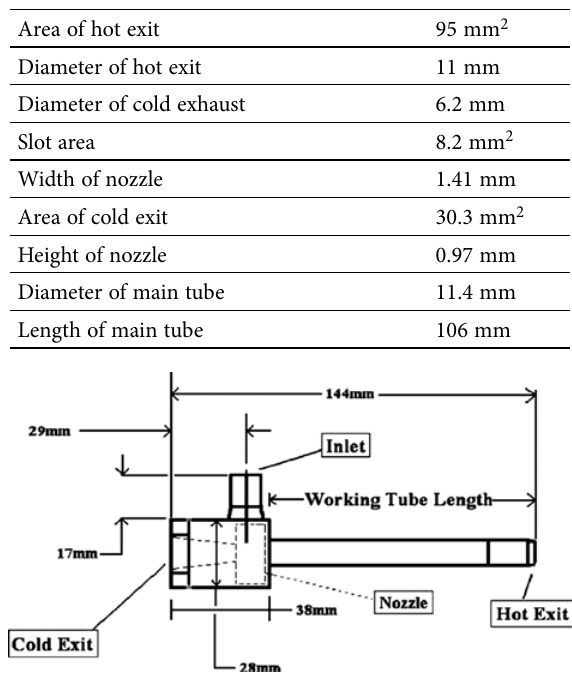
Table 1. Geometrical details of the CFD model which are similar to the experimental dimensions